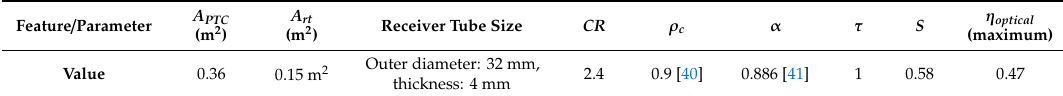
Table 1. Initial designed PTC